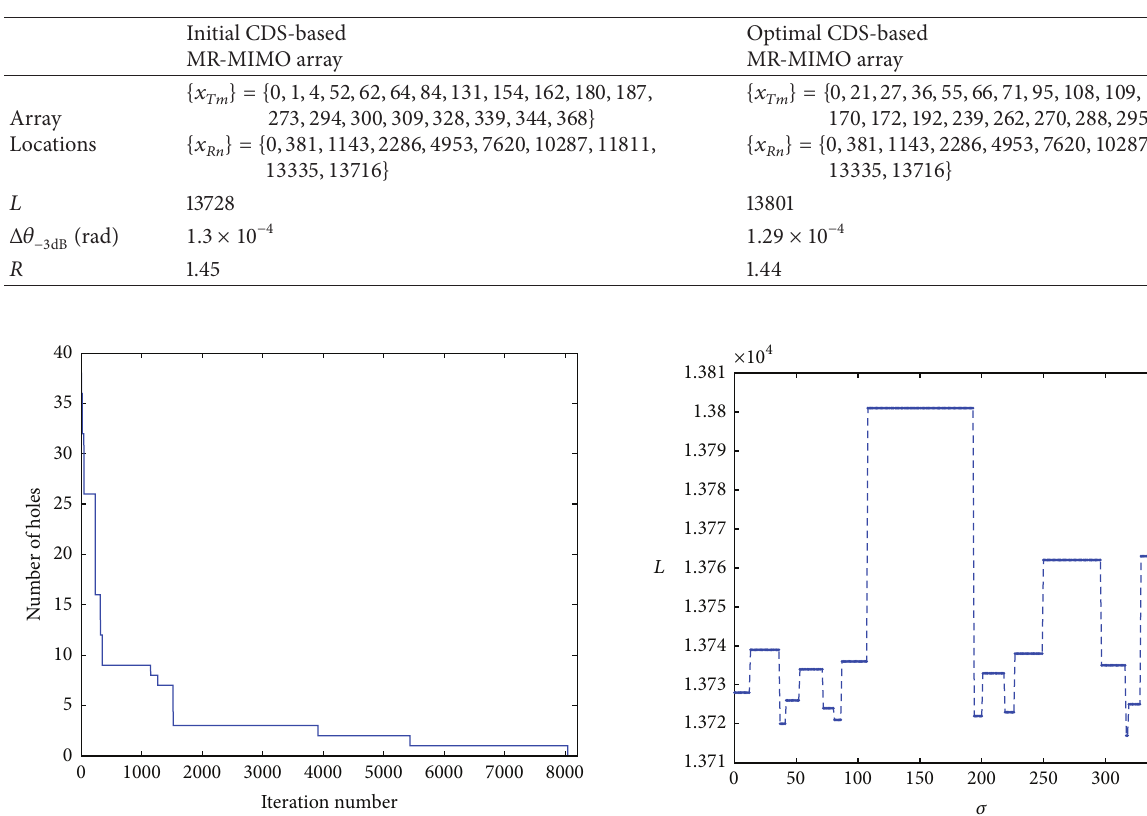
Table 2: Comparisons of different MR-MIMO layouts with their characteristics ( 𝑀 = 20 , 𝑁 = 10 ).